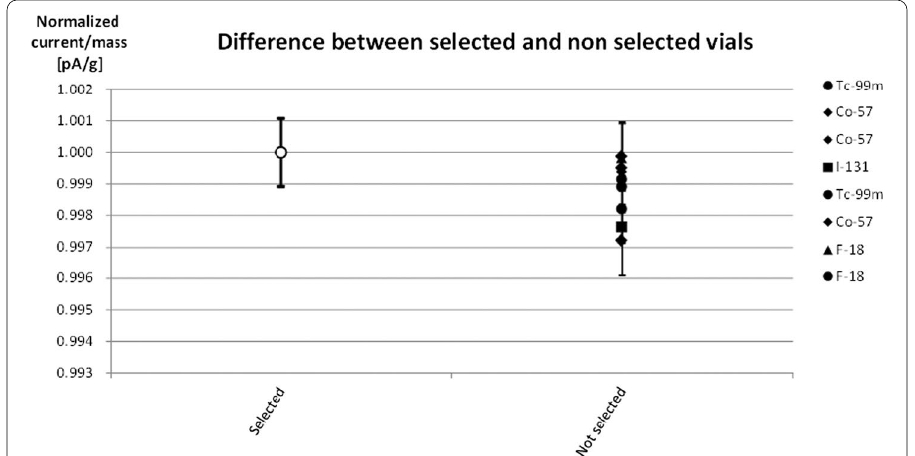
Fig. 7 Ratio between the normalized current produced in the ionization chamber by selected and non-selected vials for different